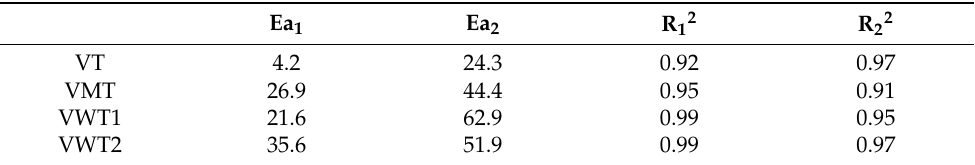
Table 1. The activation energy of catalysts’ synergistic degradation and o-DCB degradation conditions. The subscripts of “1” and “2” denote o-DCB and synergistic conditions,